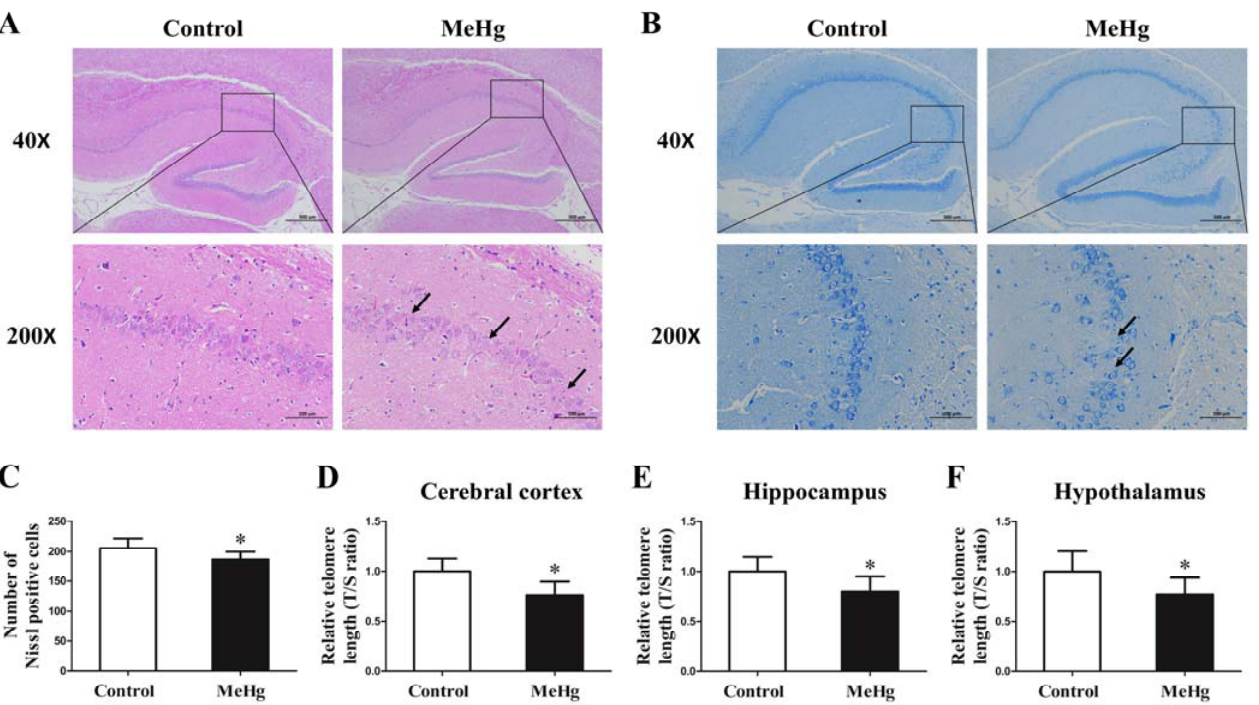
Figure 3. The influence of MeHg exposure on pathological morphology of rat brain tissue detected by HE staining ( A ) and Nissl staining ( B , C ) as well as the telomere length in cerebral cortex ( D ), hippocampus ( E ) and hypothalamus ( F ). The pyramidal cells in the regions indicated by black arrows was decreased and showed an irregular arrangement. The data are expressed as mean ± SD for eight rats per group. * p < 0.05, significant difference compared to the control group.